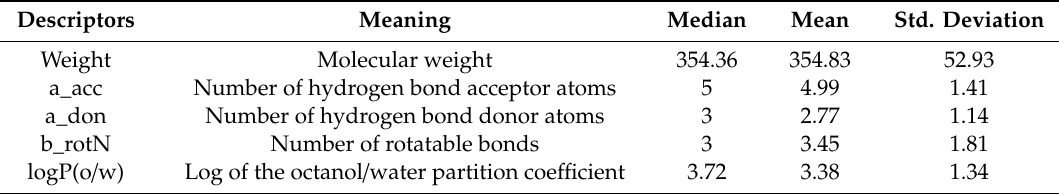
Table 1. Drug-like property descriptors of 181 compounds in licorice.